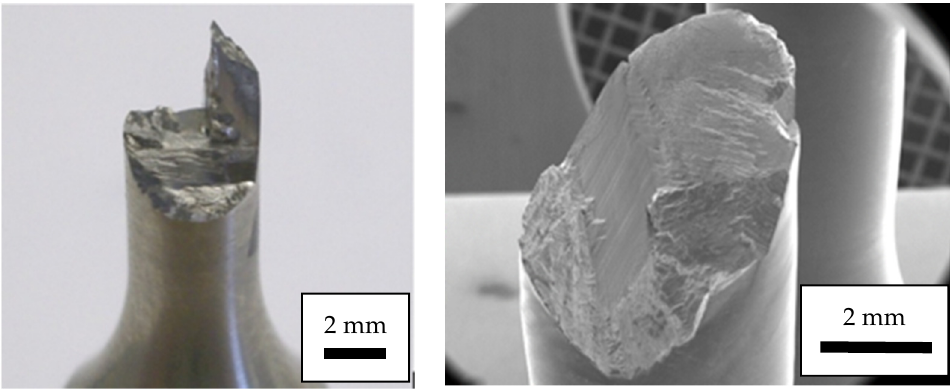
Figure 13. Load controlled fatigue data from cyclic and dwell testing.